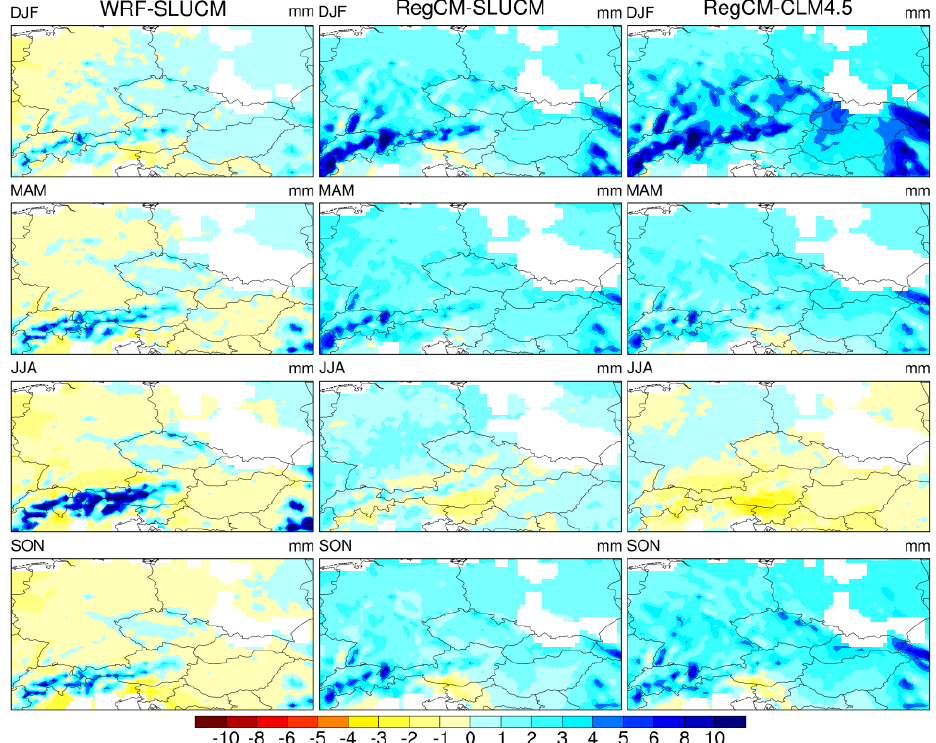
Figure 4. Spatial distribution of averaged daily precipitation biases (mm) for individual seasons and simulations. The white colour indicates missing reference